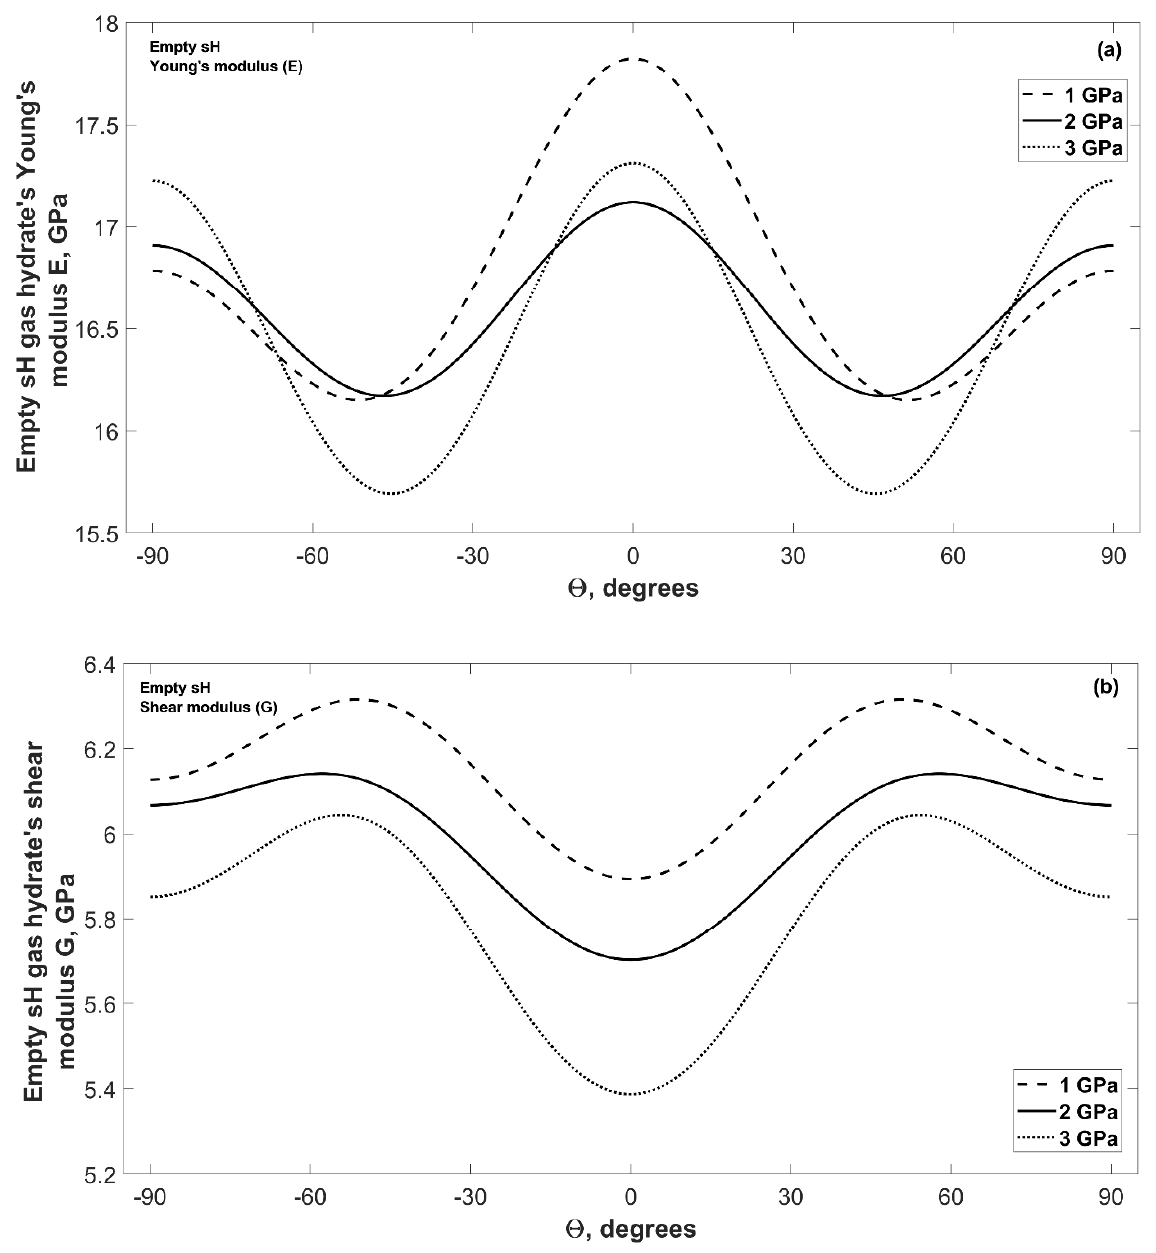
Figure 7. Direction-dependent Young’s E ( a ) and shear G ( b ) moduli of empty sH gas hydrate at different pressures and 0 K.